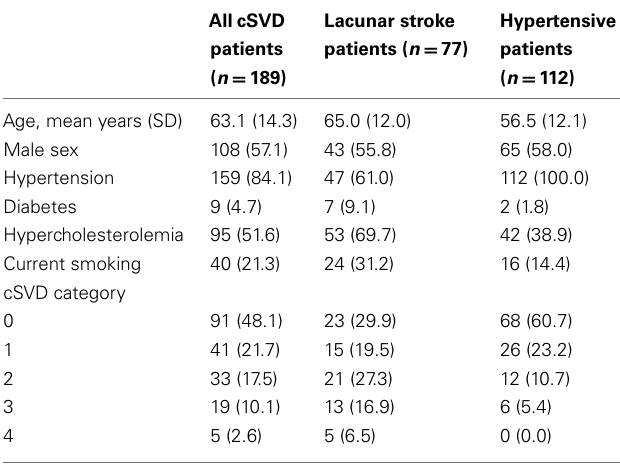
Table 1 | Patient characteristics and frequencies of cSVD